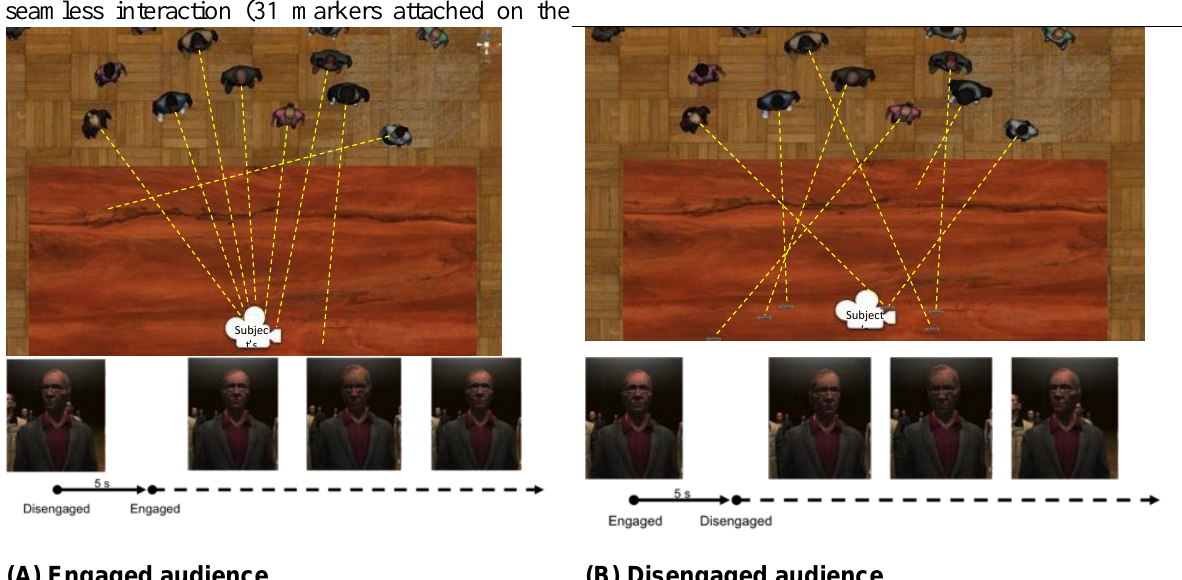
Figure 2 . In the engaged audience (A), a large part of the avatars is gazing at the musician, a small part of them looks at random targets; in the same time, a small part of the avatars looks at the musician for brief moments. In the disengaged audience (B), each avatar looks at a random target moving in random direction around the musician [range: ±4 m (left-right); ±3 m (up-down); ±1 m (front-back)] ; in the same time, a small part of the avatars looks at the musician for brief